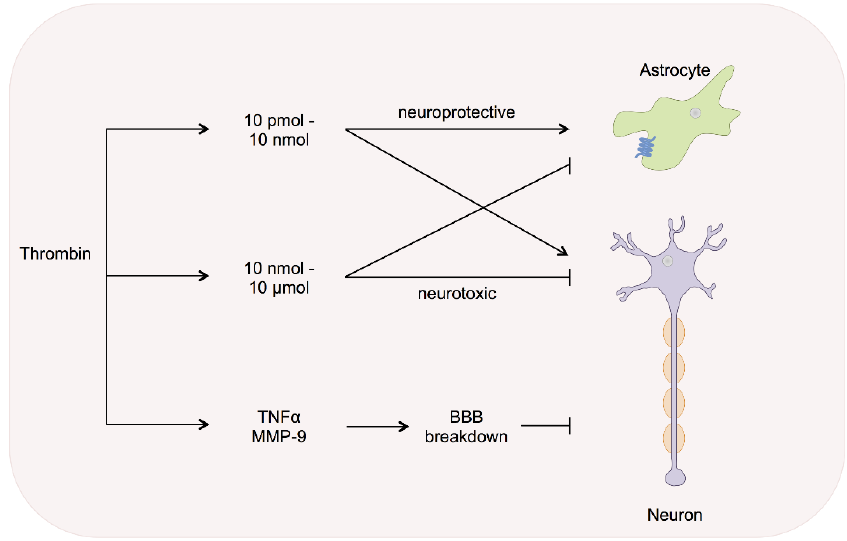
Figure 4. Stroke/intracerebral haemorrhage. Ischemia of brain-tissue leads to an increase in local thrombin and to thrombin influx via BBB breakdown. Thrombin concentrations in pico- to nanomolar range (10 pM–10 nM) are shown to protect hippocampal neurons and astrocytes from a variety of cellular insults. In sharp contrast, for higher concentrations in nano- to micromolar range (10 nM–10 μM) adverse effects, such as increased death of motor neurons and cells of the hippocampus, are documented. Oedema formation after ICH is linked with BBB breakdown and increased thrombin infusion leading to TNF- α and MMP -9 up-regulation. The release of proinflammatory factors contributes to neuroinflammation and neurodegeneration.